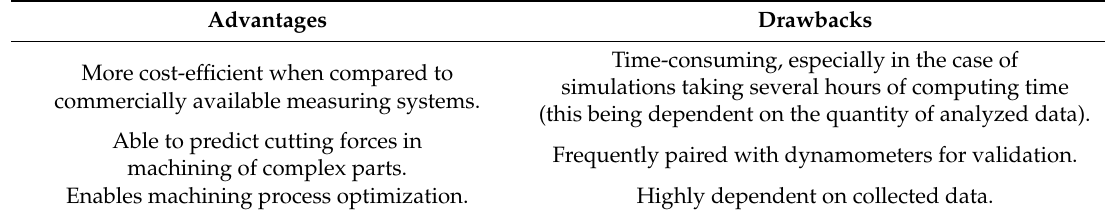
Table 4. Common advantages and drawbacks of force-prediction